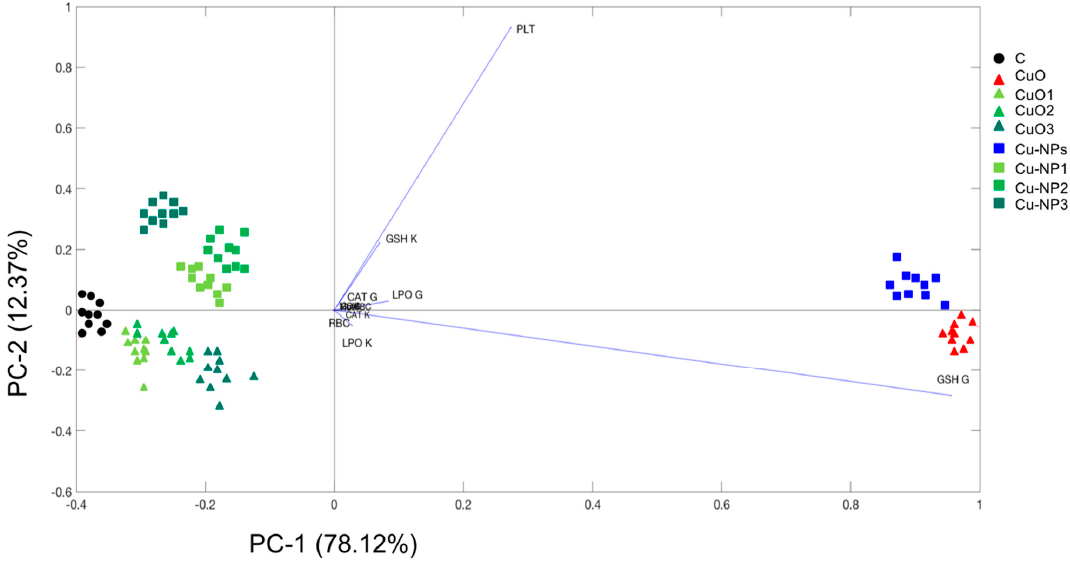
Figure 6. PCA of multiple biomarker parameters (Cu G and Cu K: bioaccumulation of Cu in gills and kidney, respectively; Hb: hemoglobin; Hct: hematocrit, RBC: red blood cells; WBC: white blood cells; MCV: mean cell volume; PLT: platelets; LPO G and LPO K: lipid peroxidation in gills and kidney, respectively; GSH G and GSH K: glutathione in gills and kidney, respectively; CAT G and CAT K: catalase in gills and kidney, respectively) measured in common carps exposed to CuO (red triangles) and Cu-NPs (blue squares), CuO and three different dosages of MFSE (light, medium and dark green triangles for CuO1, CuO2, and CuO3, respectively), Cu-NPs and three different dosages of MFSE (light, medium and dark green squares for Cu-NP1, Cu-NP2, and Cu-NP3, respectively), and the control group (C, black circles).